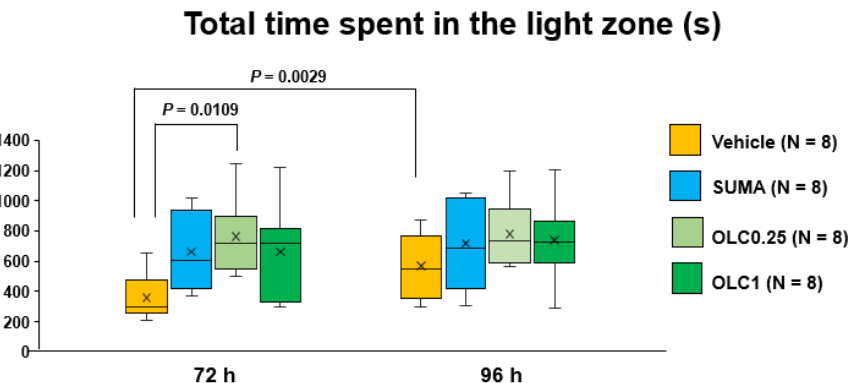
Figure 3. Total time spent in the light zone in each group. Data are plotted in the box-and-whisker box. The ordinate represents the sum of time spent in the light zone. Statistical analysis was performed using the two-way repeated measures ANOVA with effective matching to evaluate the effects of time and pharmacological interventions. Multiple comparisons were made by Sidak’s test. N = 8 in each group. Vehicle: Vehicle group, SUMA: Sumatriptan group, OLC0.25: Olcegepant 0.25 mg group, OLC1: Olcegepant 1 mg group.